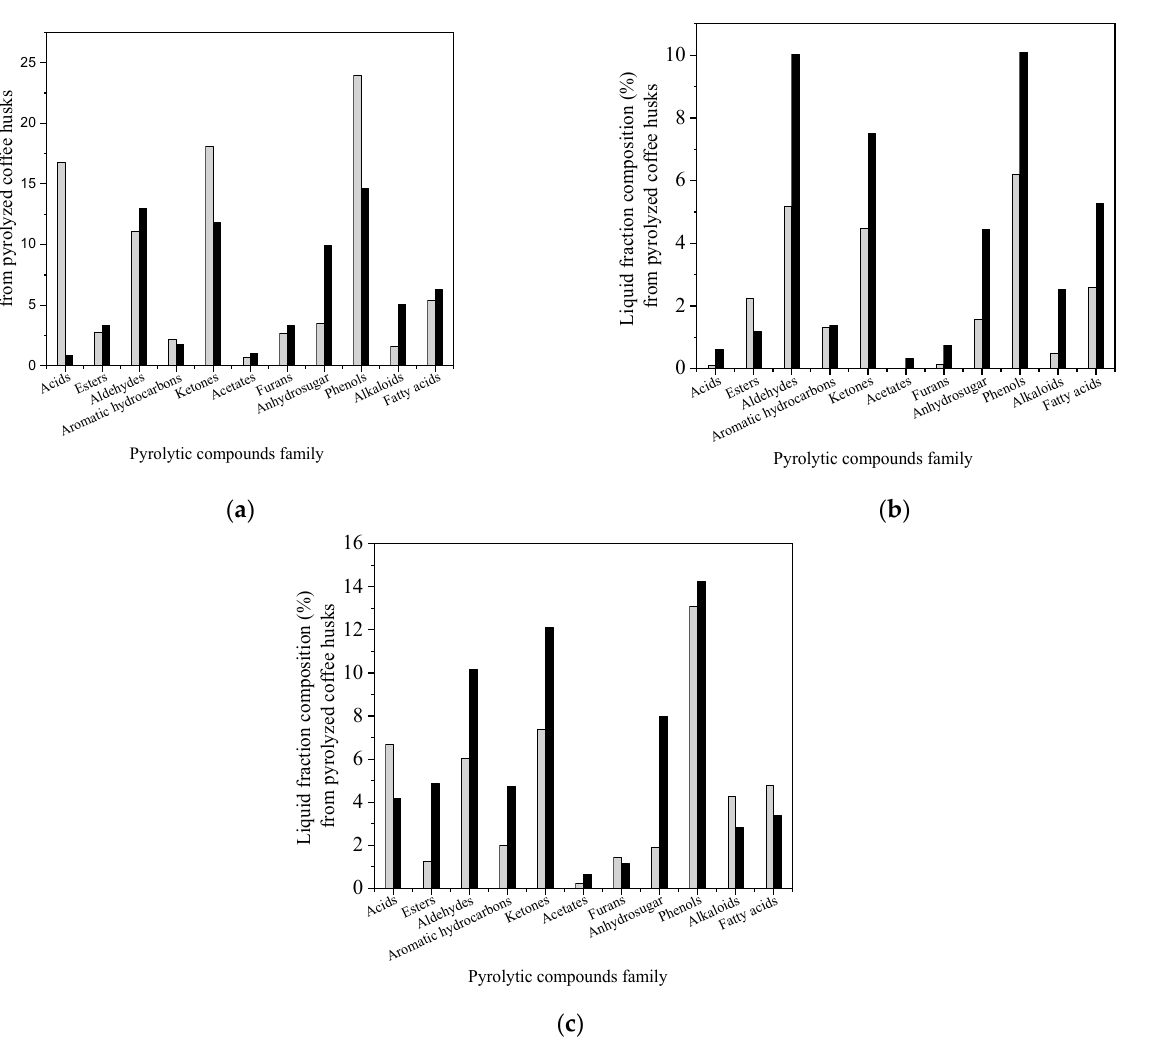
Figure 4. Pyrolytic compounds in the liquid fraction obtained from untreated and acetic acid (10%) washed coffee husks after fast pyrolysis at: ( a ) 400 °C; ( b ) 500 °C; ( c ) 600 °C. Symbols: untreated biomass; treated biomass.